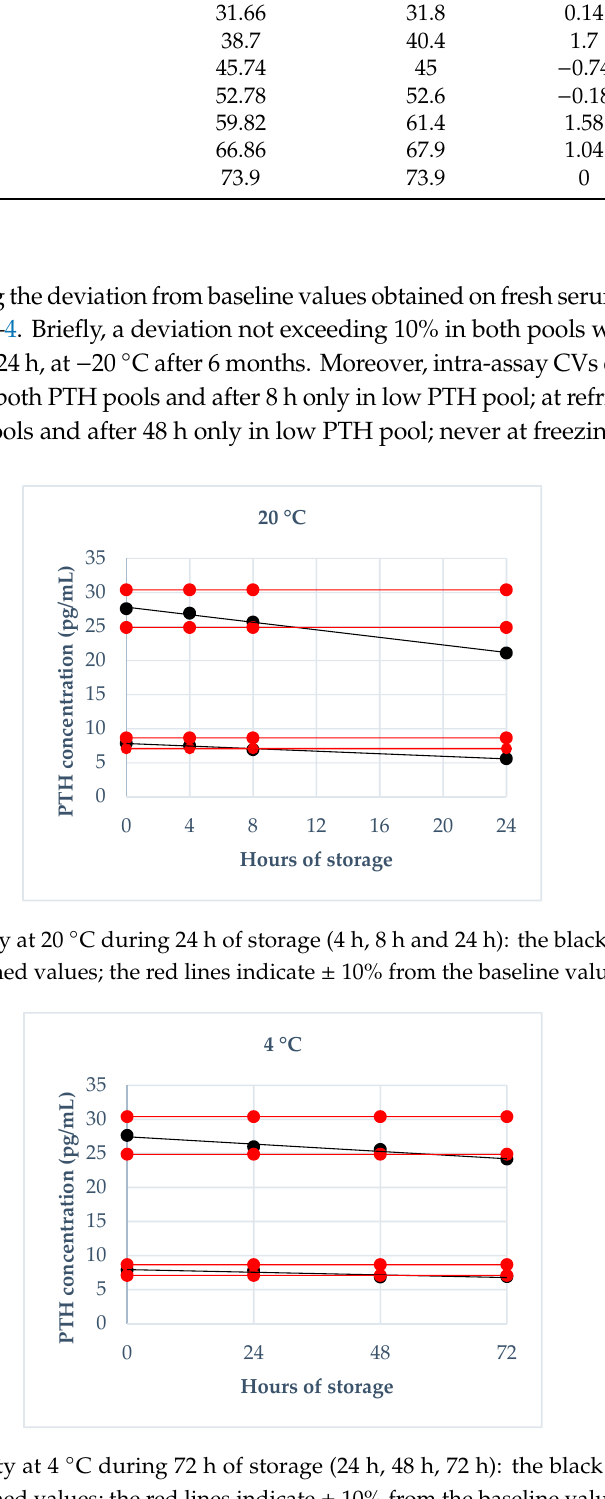
Figure 4. PTH stability at − 20°C during 180 d of storage (7 d, 30 d, 180 d): the black lines indicate the tendency of the obtained values; the red lines indicate ± 10% from the baseline value. 3.4. Clinical Validation A total of 21 samples from 15 nephropatic dogs were obtained: sCr was available for all samples, while p was measured in 18 of 21. Median sCr was 2.96 mg/dl (0.9 − 18.06) and median p was 4.55 mg/dl (2.3–14.7). PTH was significantly positively associated with sCr ( p < 0.01, ρ = 0.93) and p ( p < 0.01, ρ = 0.79), as reported in Figure 5. PTH was also significantly different among IRIS stages, grouped as reported in Figure 6: 0 vs. 1–2 ( p = 0.0168), 0 vs. 3–4 ( p = 0.0022), 1–2 vs. 3–4 ( p = 0.0067).